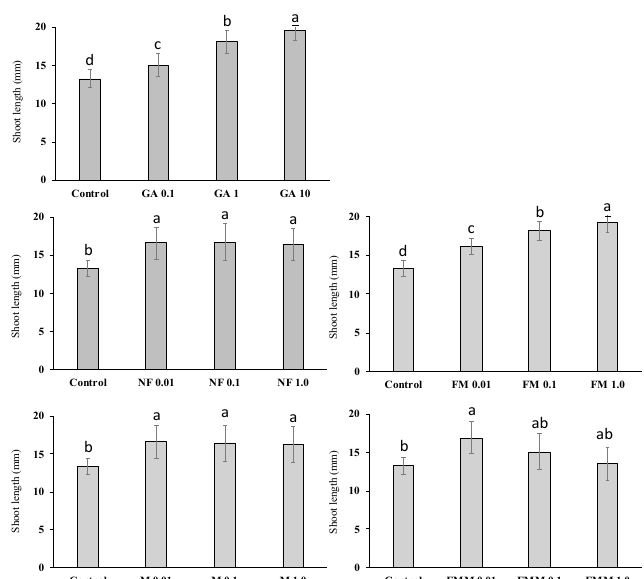
Figure 3. Auxin-like activity of HS from earthworm coprolites collected in soils fertilized with no inputs (NF), manure (FM), mineral fertilizers (M) or manure plus mineral fertilizers (FMM). Data represent the means of three measurements with ten plants in each. Values above bars following the same letter are not statistically different at p < 0.05 according to Student-Newman-Keuls test.